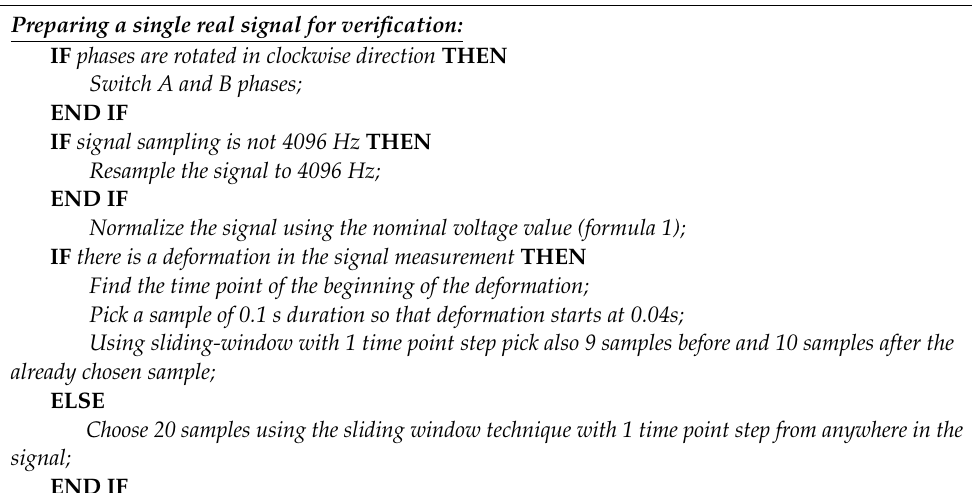
Algorithm A2 Step-by-step process of preparing a real-world measurement for